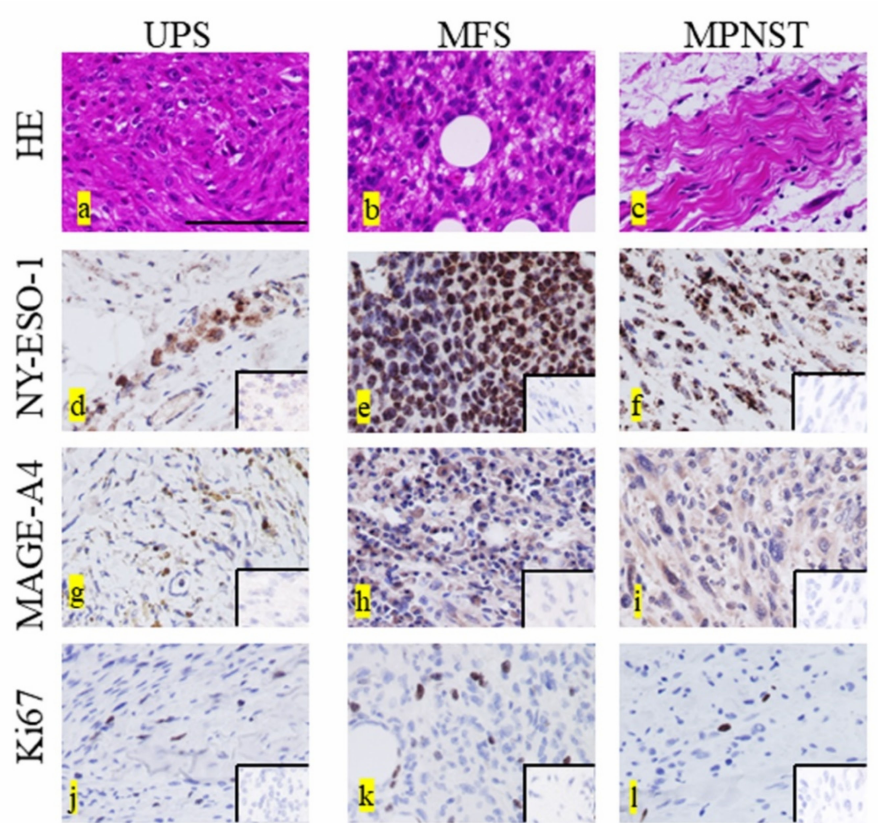
Figure 1. Representative histopathological findings in undifferentiated pleomorphic sarcoma (UPS) ( a ), myxofibrosarcoma (MFS) ( b ), and malignant peripheral sheath tumor (MPNST) ( c ). Hema- toxylin and eosin (HE) staining ( a – c ). Representative NY-ESO-1-positive histological findings in UPS ( d ), MFS ( e ), and MPNST ( f ). Representative MAGE-A4-positive histological findings in UPS ( g ), MFS ( h ), and MPNST ( i ). Representative Ki67-positive histological findings in UPS ( j ), MFS ( k ), and MPNST ( l ). NY-ESO and MAGE-A4 show staining in the cytoplasm, whereas Ki67 shows staining in the nucleus ( d – l ). The lower right inset image was used as the negative control for each immunostaining image ( d – l ). Scale bar = 100 µ